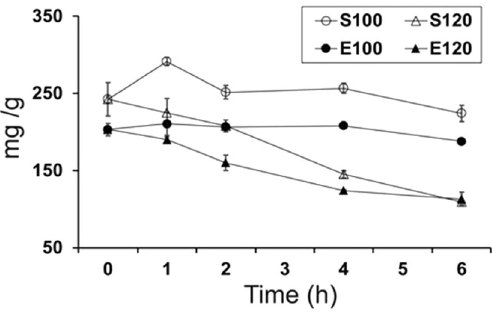
Figure 2. Changes in total contents of the 18 ginsenosides in raw and steamed ginseng pulps extracts (GPE) or extracts from ginseng pulp soaking supernatant (GPS) during steaming for 6 h at 100 °C (S100 or E100) and 120 °C (S120 or E100). Data at 0 h represent those of GPE or GPS. Values are denoted as the mean ± standard deviation (n =